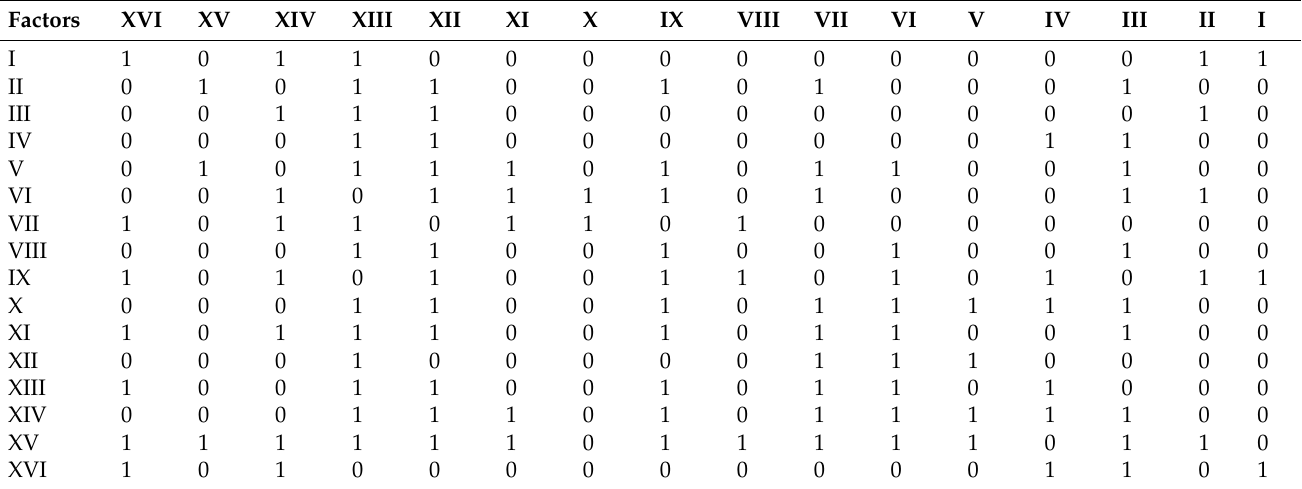
Table 3. Reachability matrix after transitivity.